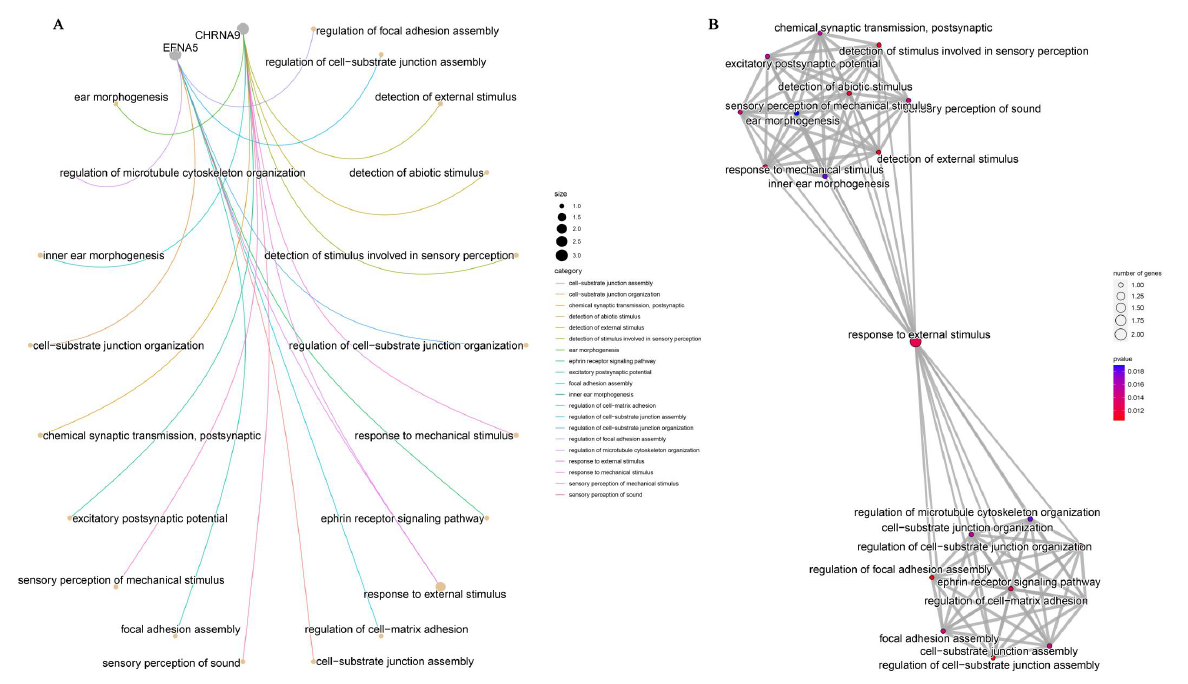
4 Figure 5. The GO annotation of candidate genes. ( A ) The GO annotation category. ( B ) The GO annotation category’s